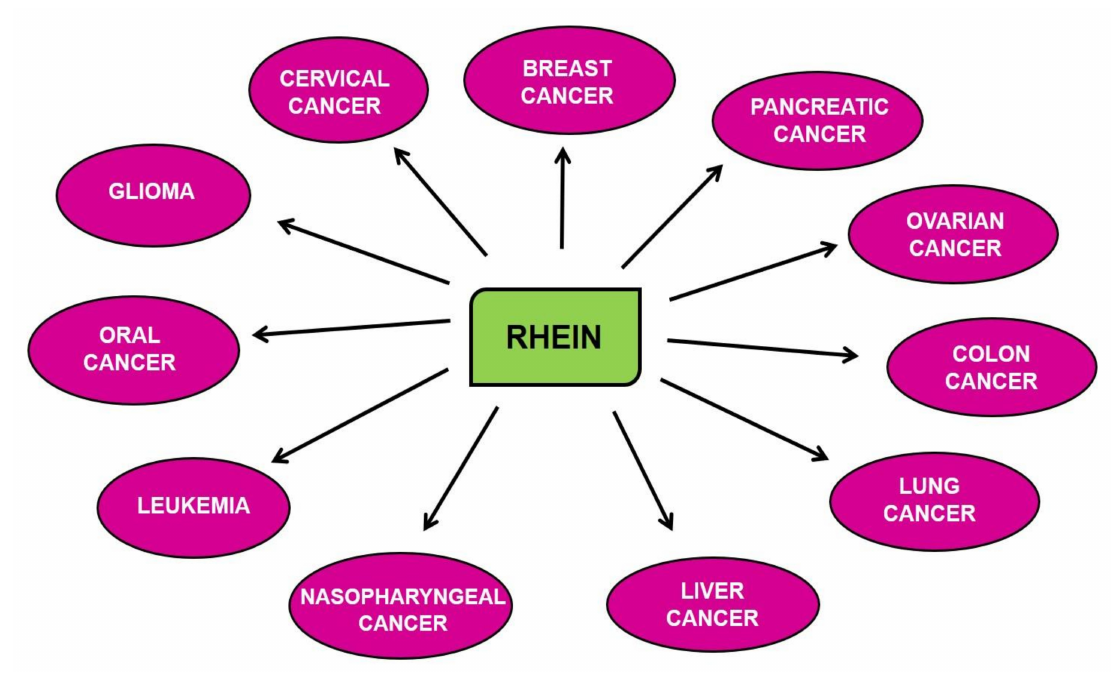
Figure 2. Anticancer activity of rhein in di ff erent